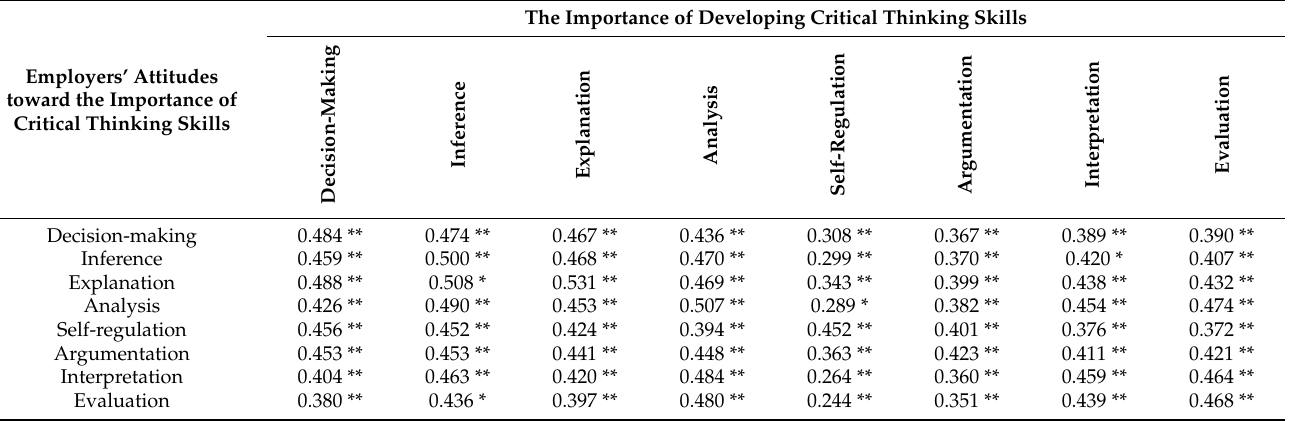
Table 7. Correlation between employees’ attitudes toward the importance of critical thinking skills and the importance of developing critical thinking